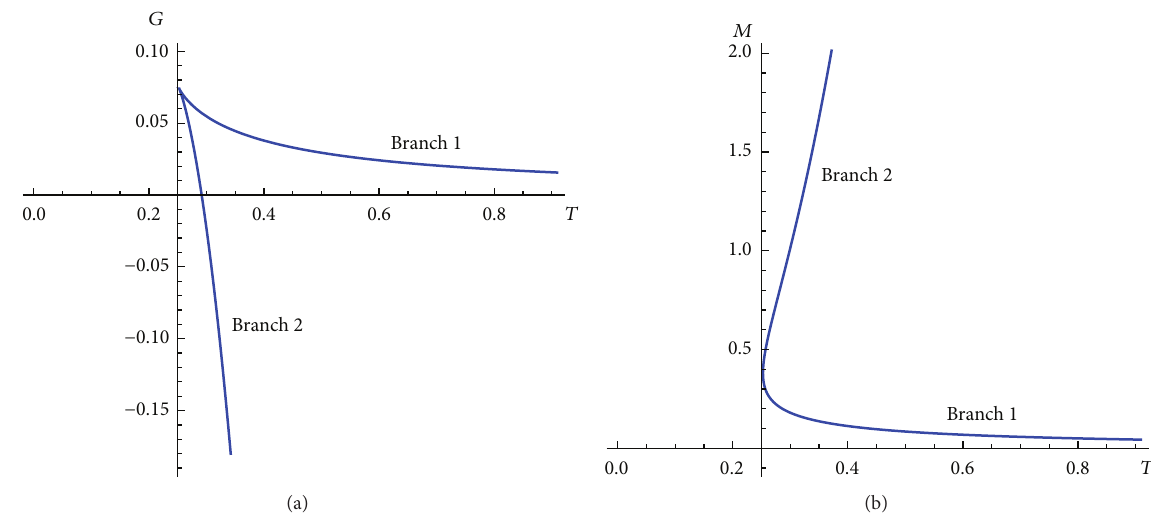
Figure 1: Example plot ( 𝑛 = 4 ) of (a) free energy 𝐺 and (b) mass versus 𝑇 for the fixed Φ < Φ 𝑐 ensemble; both 𝑛 = 3,4 show similar features.